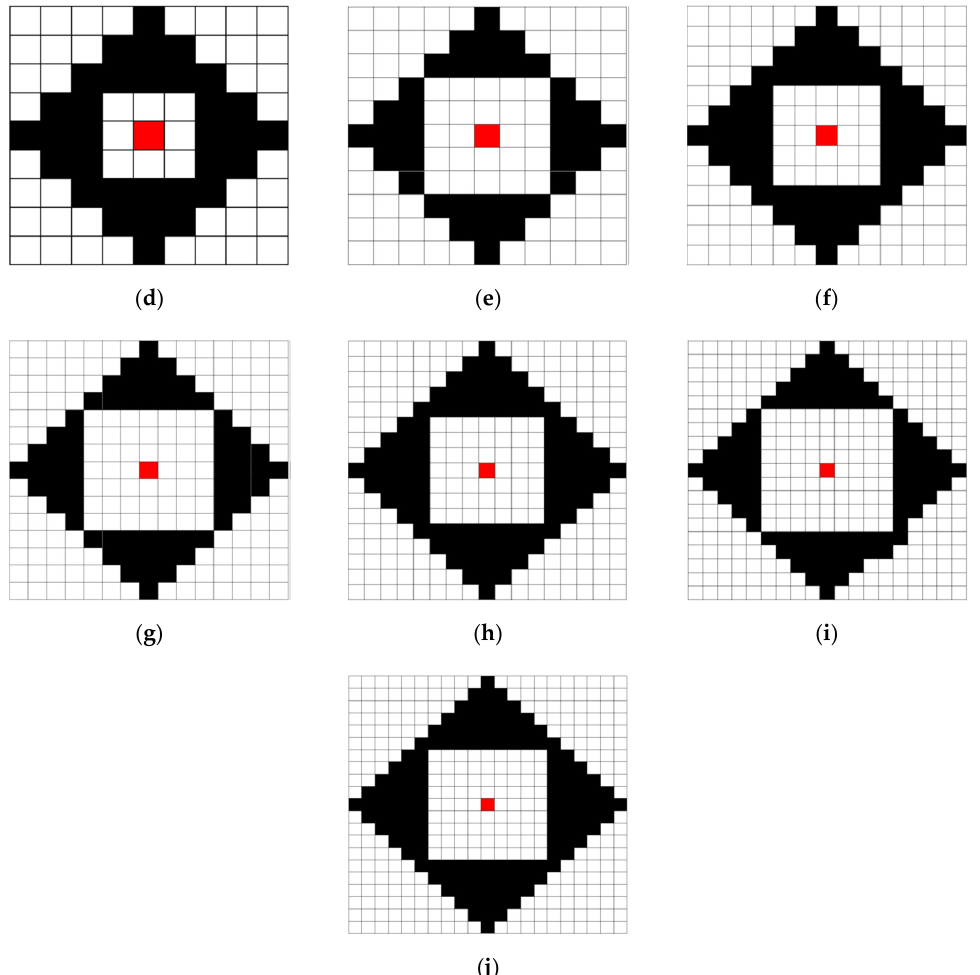
Figure 6. The selected points in the windows with a sparse census transform. ( a ) AWSCT 3 × 3, ( b ) AWSCT 5 × 5, ( c ) AWSCT 7 × 7, ( d ) AWSCT 9 × 9, ( e ) AWSCT 11 × 11, ( f ) AWSCT 13 × 13, ( g ) AWSCT 15 × 15, ( h ) AWSCT 17 × 17, ( i ) AWSCT 19 × 19, and ( j ) AWSCT 21 × 21.